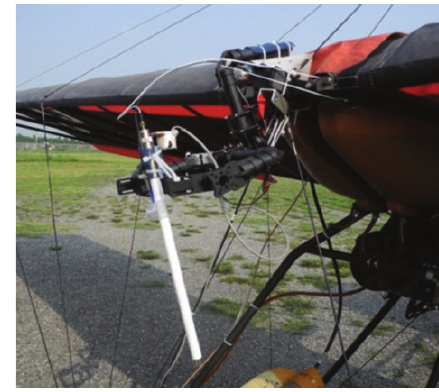
Figure 12: Airborne antenna on JJ2071 for ULAFP test.